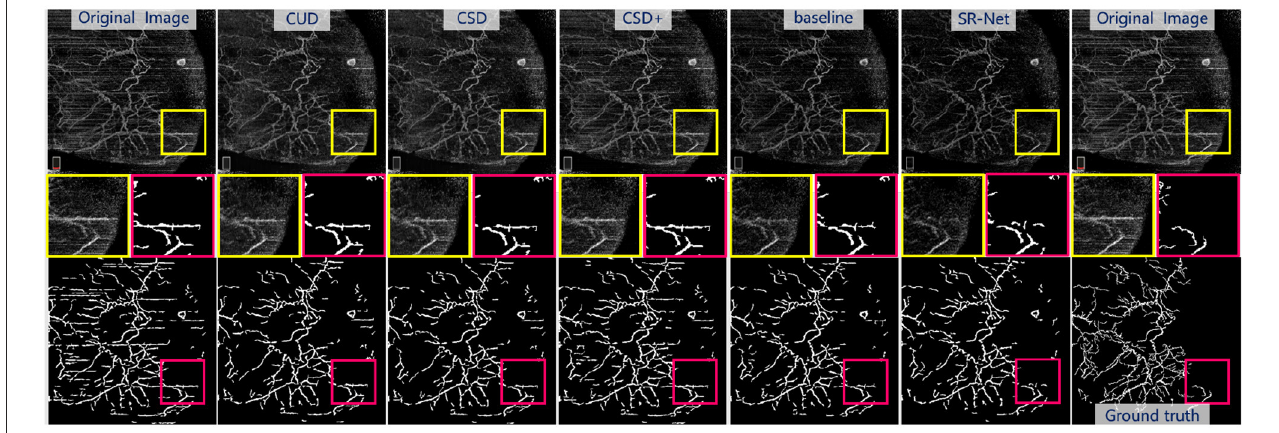
FIGURE9 Illustrative stripe removal results using different methods on a real AS-OCTA image and their vessel segmentation performance by COOF (61). Top: De-striped AS-OCTA images by different methods. Bottom: Vessel segmentation results. Middle: Representative patches of de-striping and vessel segmentation results.